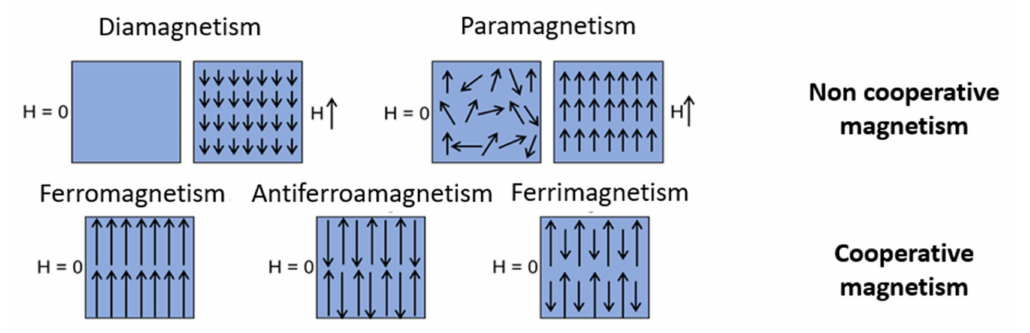
Figure 3. Representation of the arrangement of magnetic moments in materials having different magnetic behaviors. When necessary, the behavior with or without the presence of an external field H is